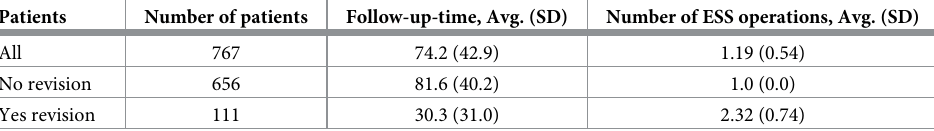
ESS = Endoscopic sinus surgery, Avg. = Average, SD = Standard